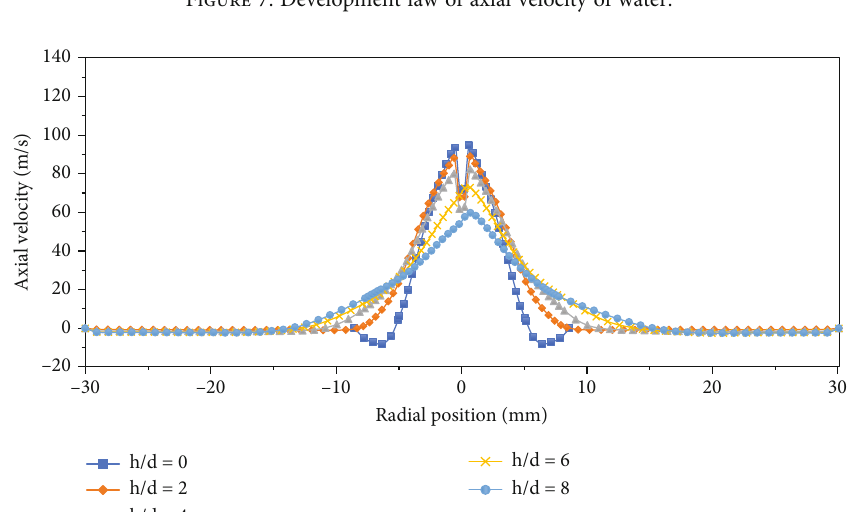
Figure 7: Development law of axial velocity of water.